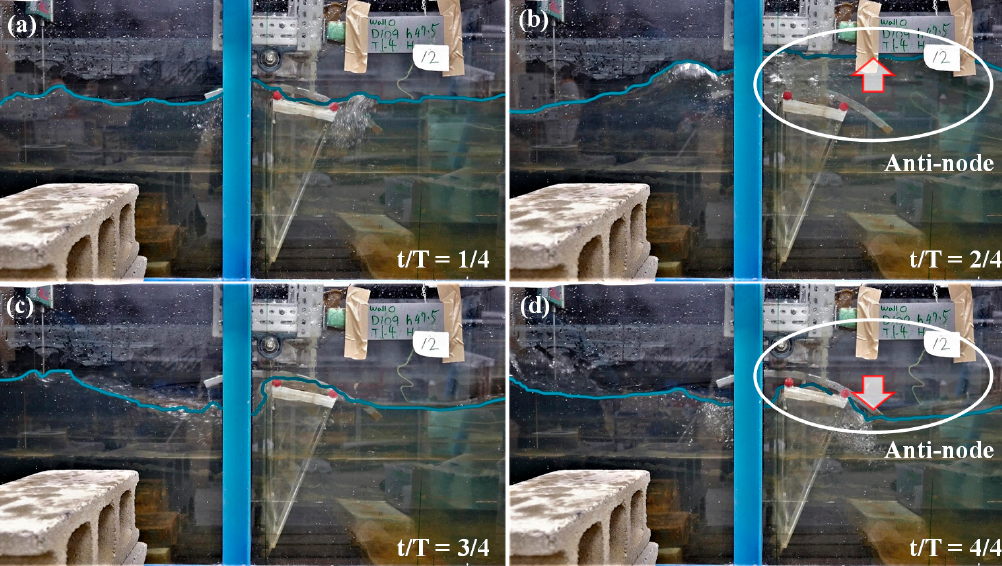
Figure 12. Screenshots for pattern D for the case of D = 1.09 m, h = 0.475 m, T = 1.4 s, and H i = 0.12 m at ( a ) t / T = 1 / 4, ( b ) t / T = 2 / 4, ( c ) t / T = 3 / 4, and ( d ) t / T = 4 / 4. D / L was 0.4306. The blue solid line denotes the water surface.